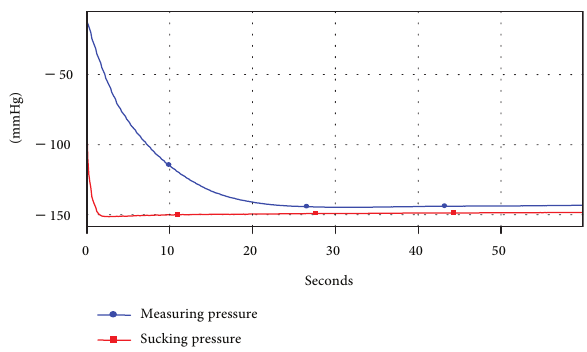
Figure 4: Performance of conventional unventilated bottle with an unvented teat.